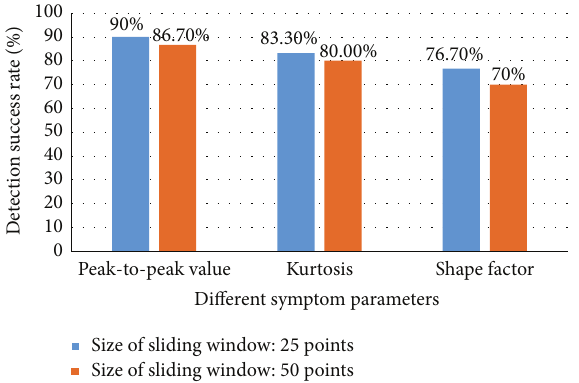
Figure 14: Size of sliding window: 25 points and 50